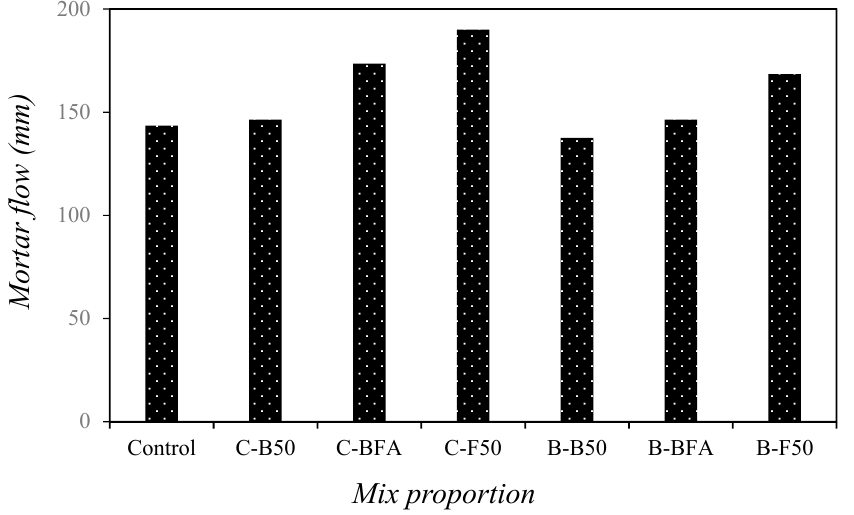
Figure 4. Changes in mortar flow with mixed fine aggregates.